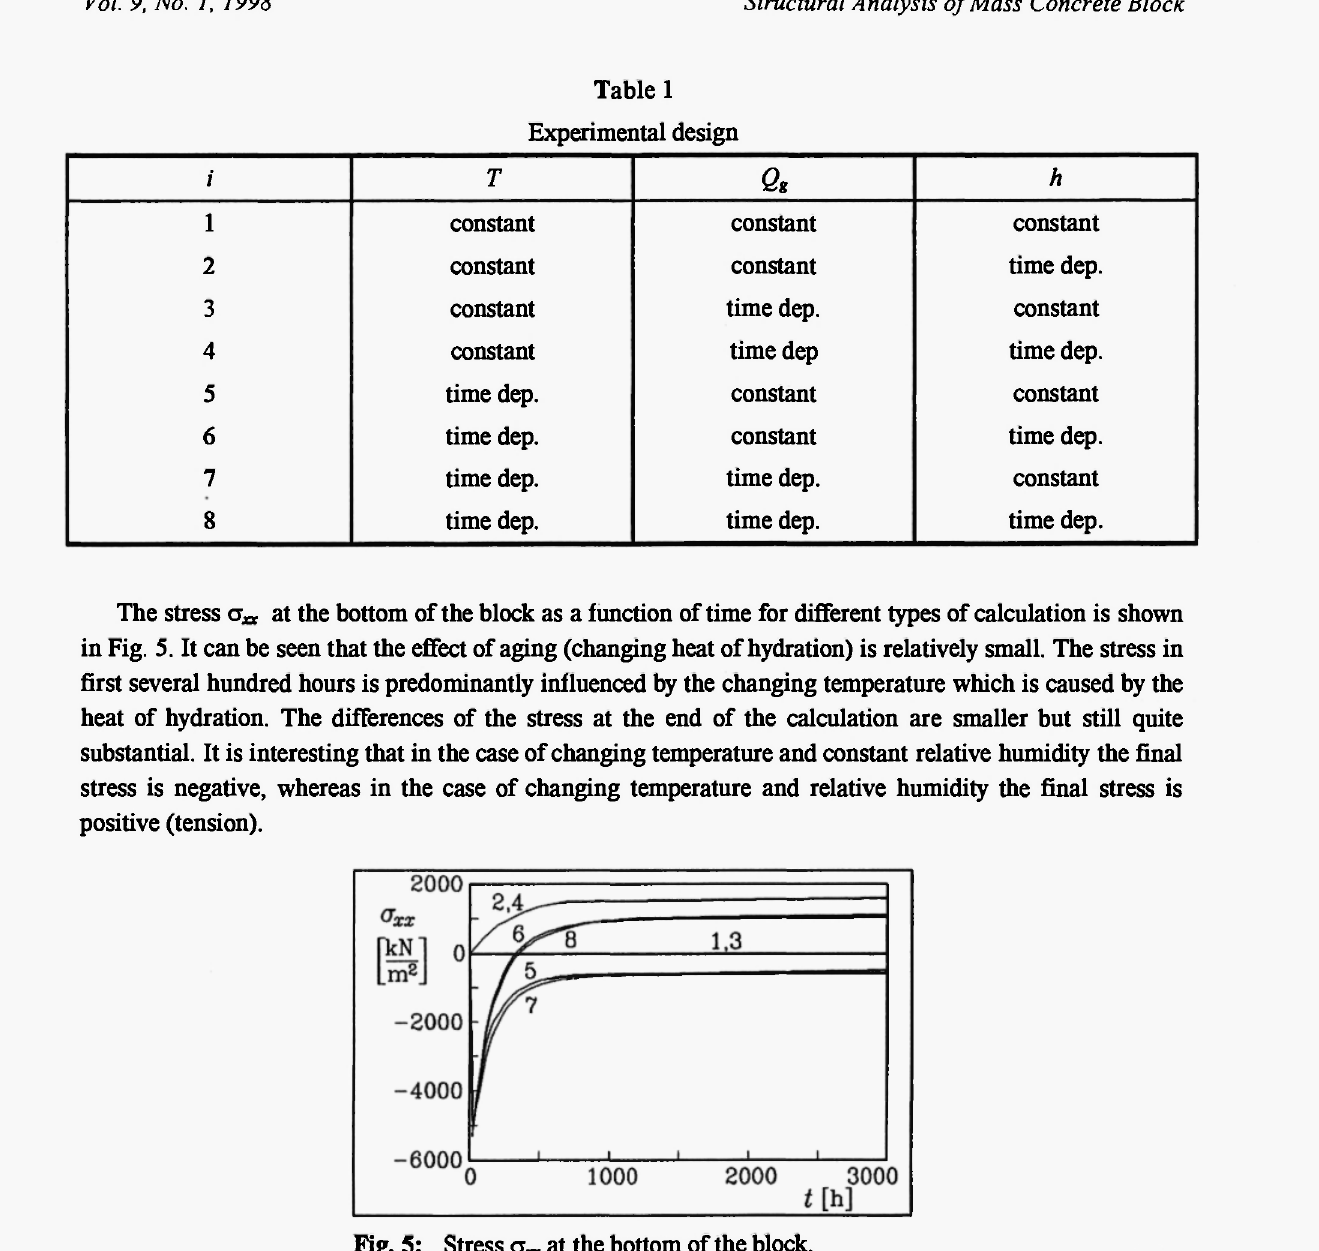
Fig. 5: Stress σ„ at the bottom of the